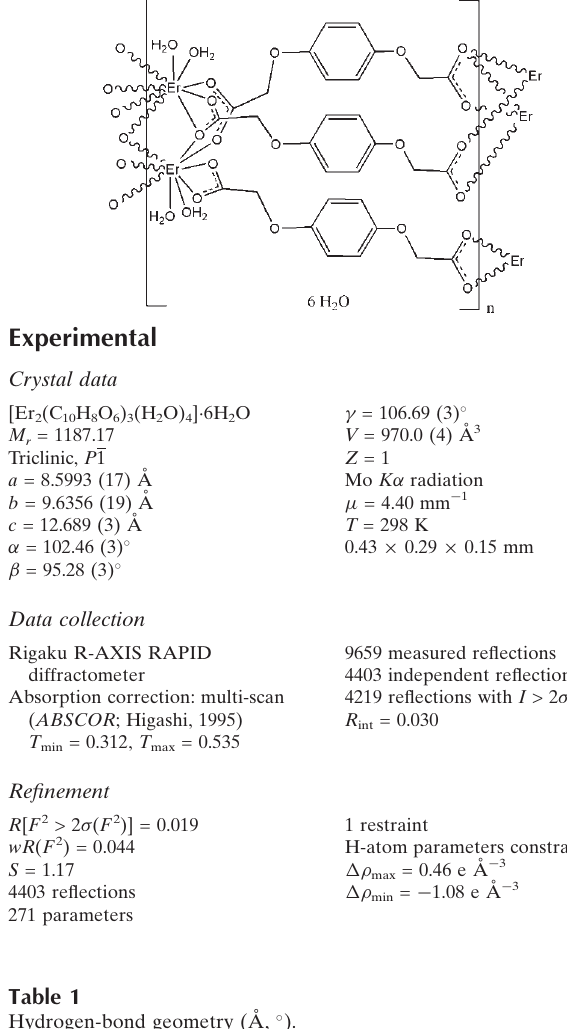
Hydrogen-bond geometry (A˚ , (cid:3) ). D —H (cid:2)(cid:2)(cid:2)